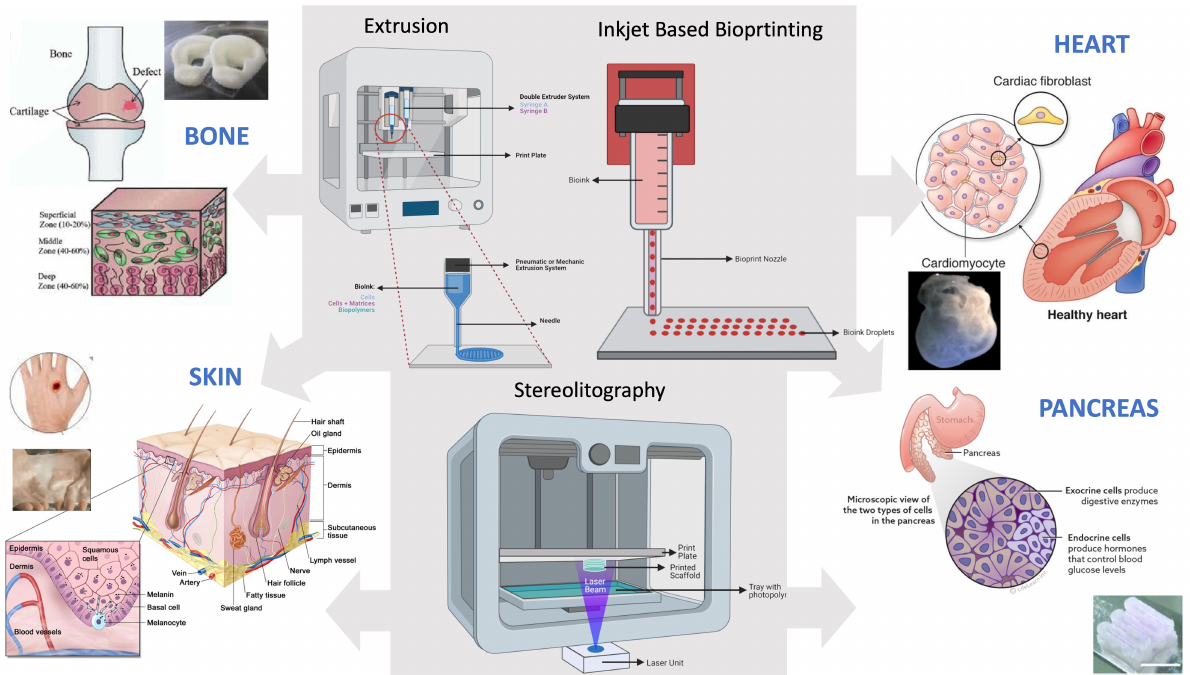
Figure 2. Main bioprinting techniques for different tissue-specific